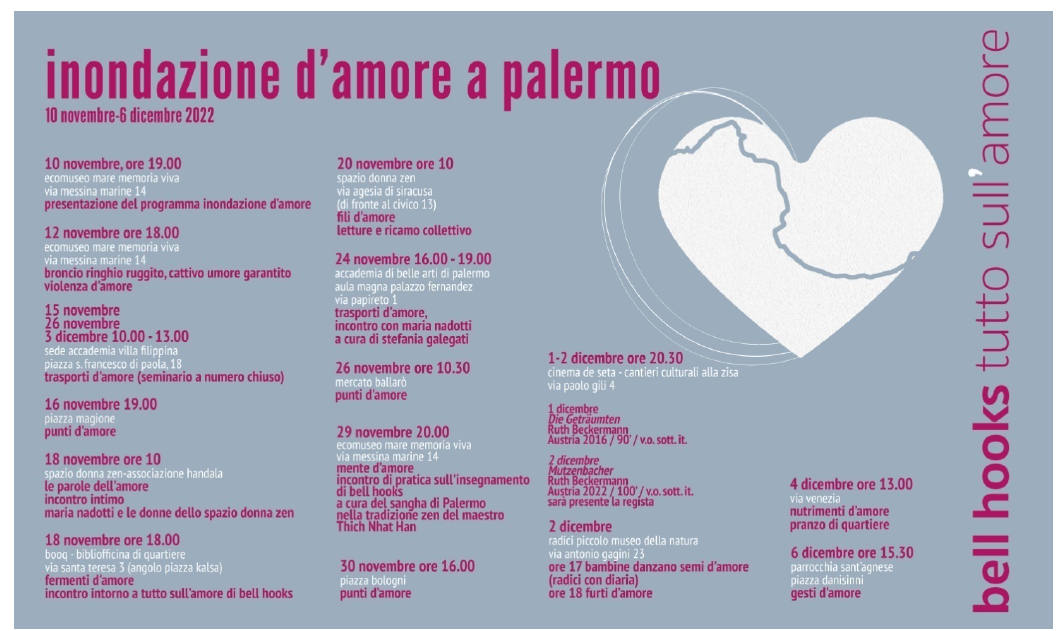
Fig. 1 : Inondazione d’amore a